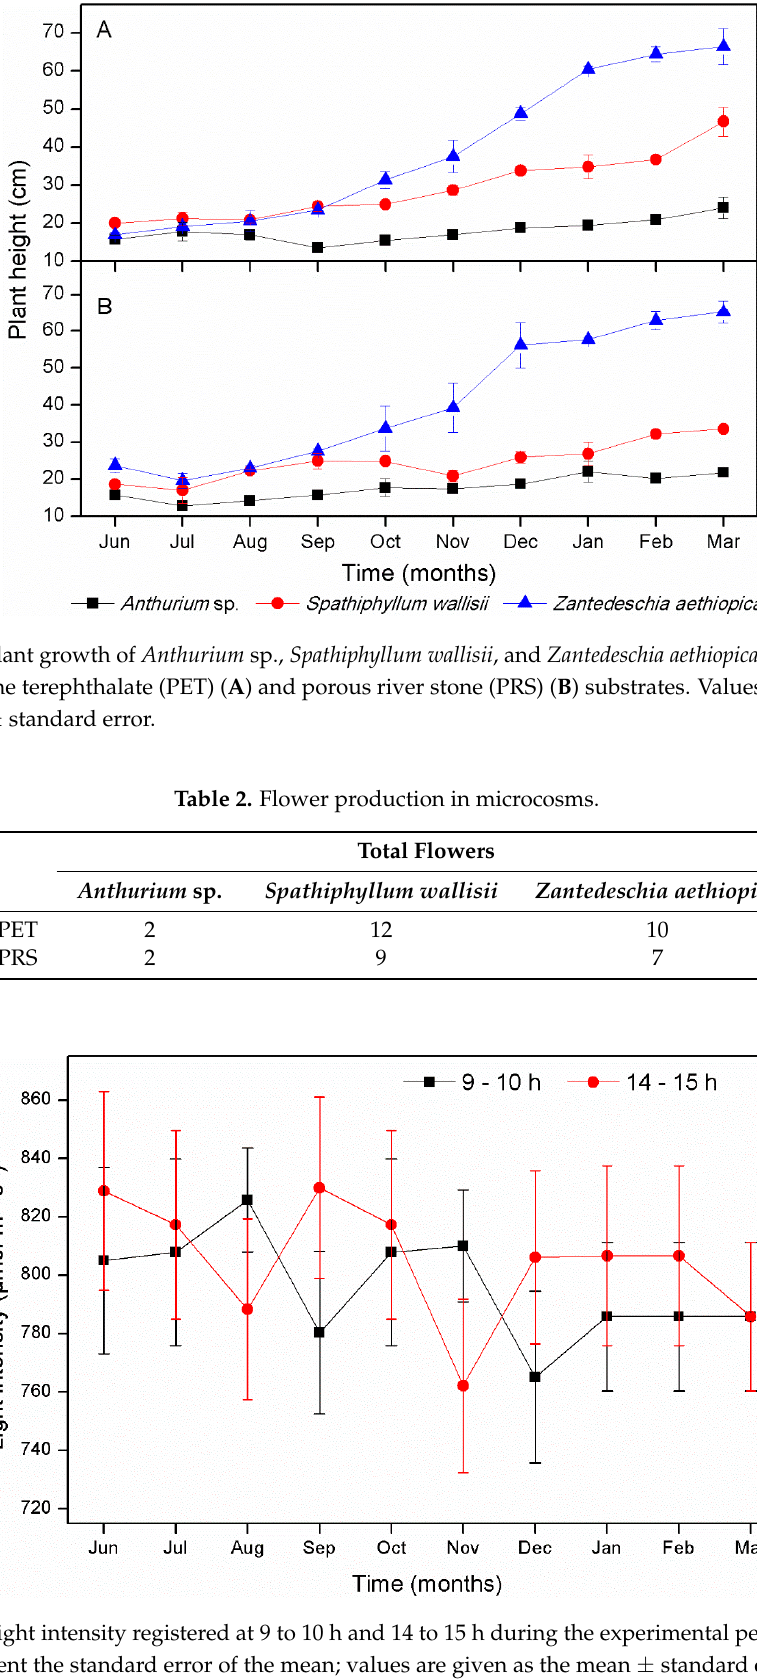
Table 1. Wetland plants in different substrates. Chemical parameters at the inlet and outlet of wetland microcosms.